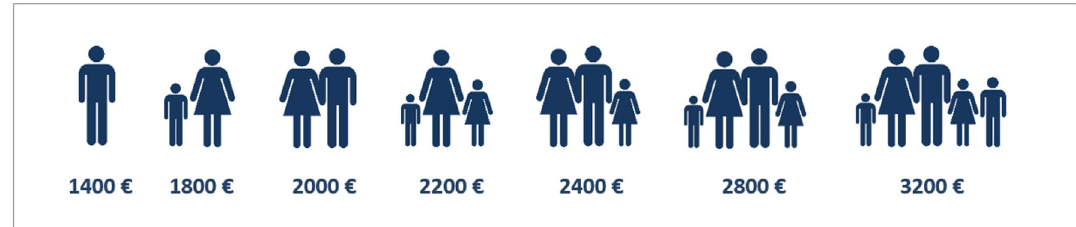
Fig. 2 Income thresholds for the interviewees (net household income per